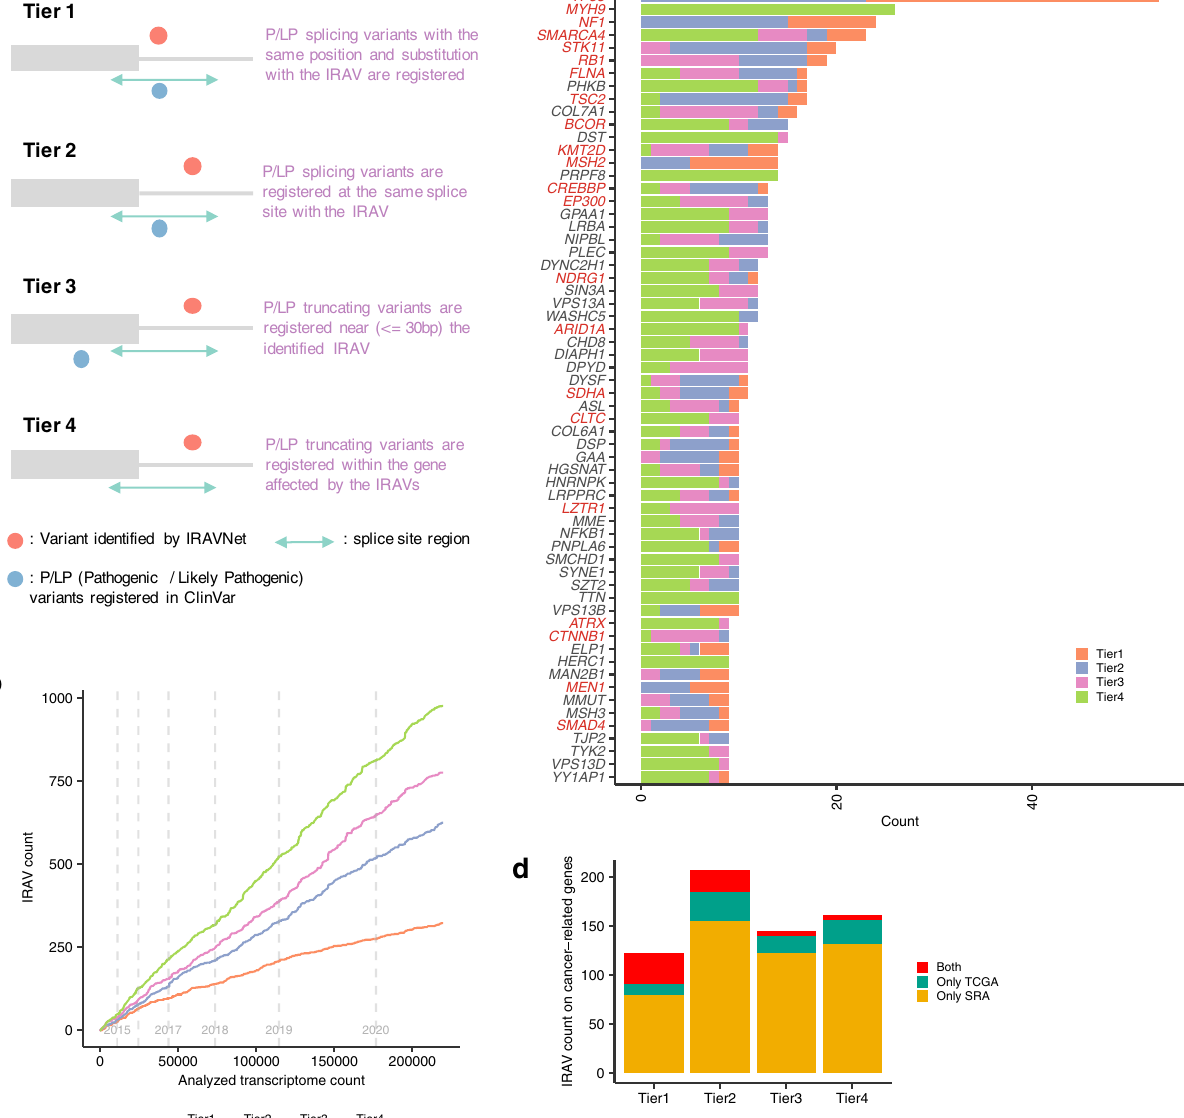
transcriptome is shown. Gray vertical lines indicate the registration year changes. c The landscape of putative pathogenic IRAVs for frequently altered genes (total number ≥ 10). Genes were sorted by the total number of distinct variants, and known cancer-related genes are shown in red. d The number of distinct putative pathogenic IRAVs affecting cancer-related genes for each rank identi fi ed from Sequencing Read Archive, TCGA, and